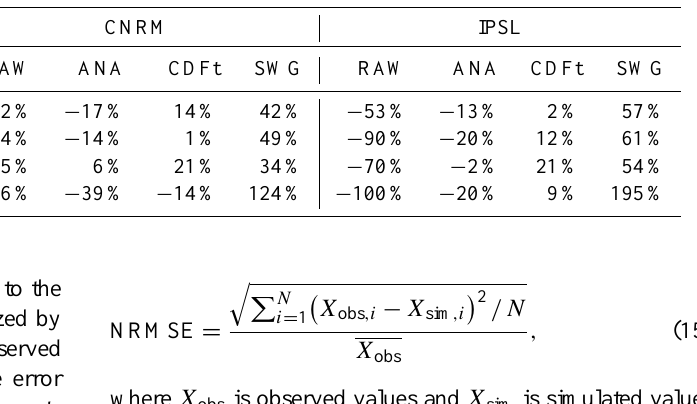
Figure 5. Flowchart illustrating the method used to compare the three downscaling methods through a hydrological sensitivity analysis. Table 2. Cumulative volume error (VE C ) between hydrological simulations based on downscaled or raw climate data (ANA, CDFt, SWG, RAW) and the reference (REF). Values are expressed in % of difference in the total volume of water flowed during the